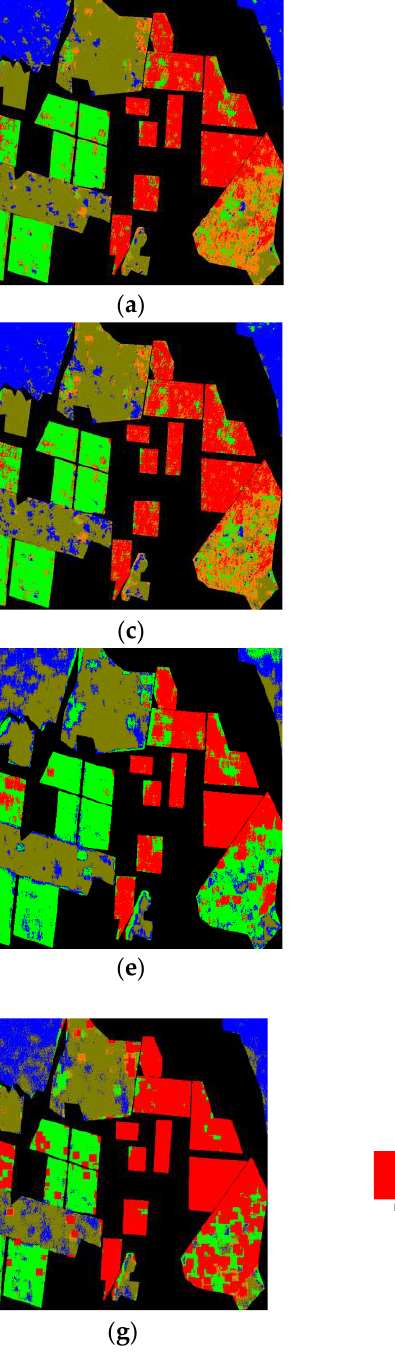
Figure 12. The classification result maps on the SanFrancisco-Bay SAR image: ( a ) The classification results of the GCA-CNN; ( b ) The classification results of the SI-CNN; ( c ) The classification results of the OI-CNN; ( d ) The classification results of the GHFM-CNN; ( e ) The classification results of the DBN; ( f ) The classification results of the SAE; ( g ) The classification results of the SVM.